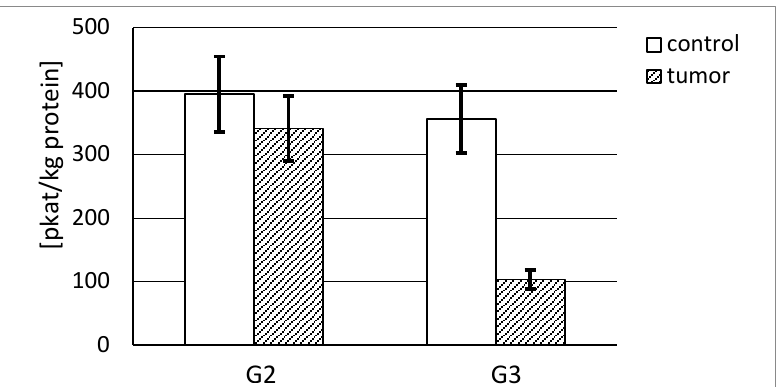
Figure 8. MMP-10 actual activity in human kidney tumor (G2 grade and G3 grade) and respective control tissue. p < 0.001—cancer vs. respective control kidney; p < 0.001—G3 grade vs. G2 grade human kidney cancer.